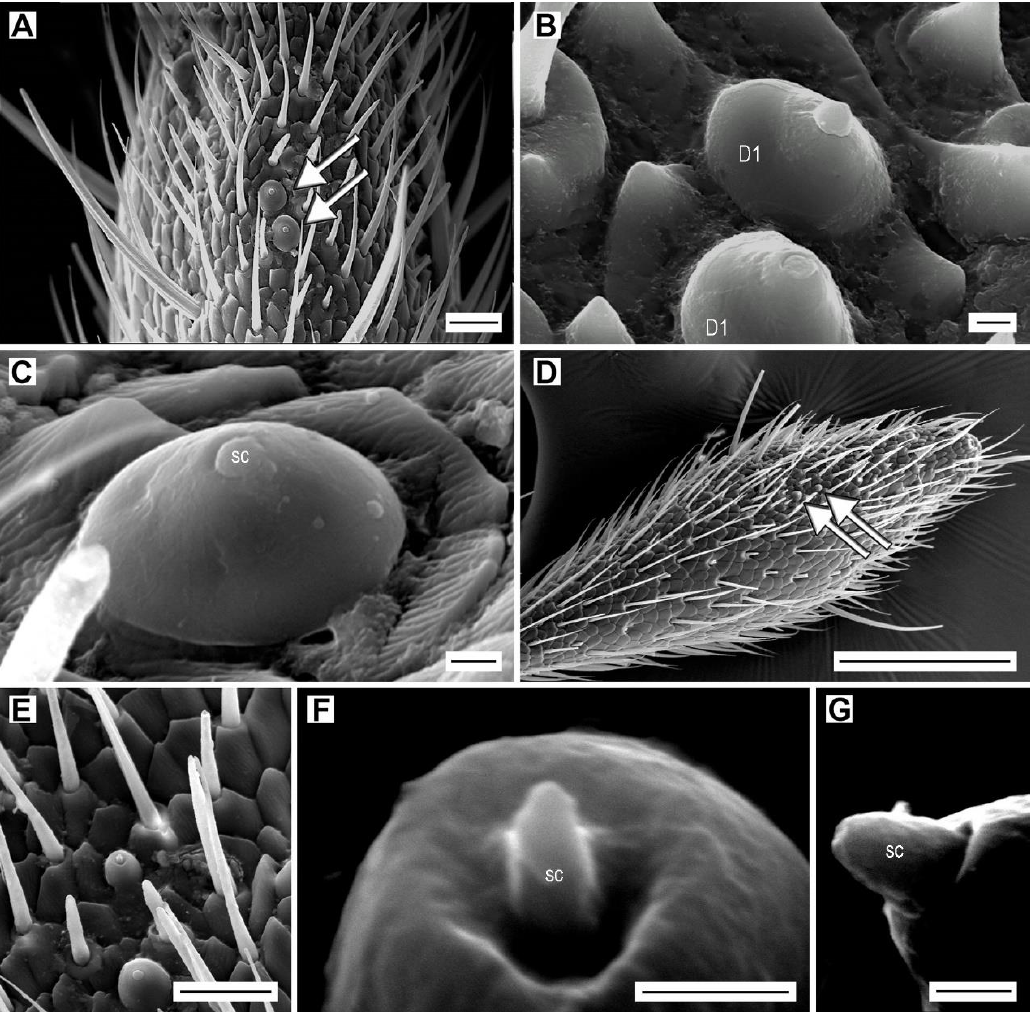
Figure 9. Dome-shaped sensilla. ( A ) A. acuminatus , male, location of dome-shaped sensilla D1 (arrows) on antennomere XI; ( B ) detail of dome-shaped sensilla D1; ( C ) A. rufipalpis , female, dome-shaped sensillum D1 showing the sensory cone (sc); ( D ) A. medvedevi , male, location of dome-shaped sensilla D2 (arrows) on antennomere XI; ( E ) A. medvedevi , male, two dome-shaped sensilla D2; ( F ) A. medvedevi , male, detail of the sensory cone of sensillum D2; ( G ) A. acuminatus , male, detail of the sensory cone of sensillum D2. Scale bars = ( A , E ): 10 μm; ( B , C , F , G ): 1 μm; ( D ) = 100